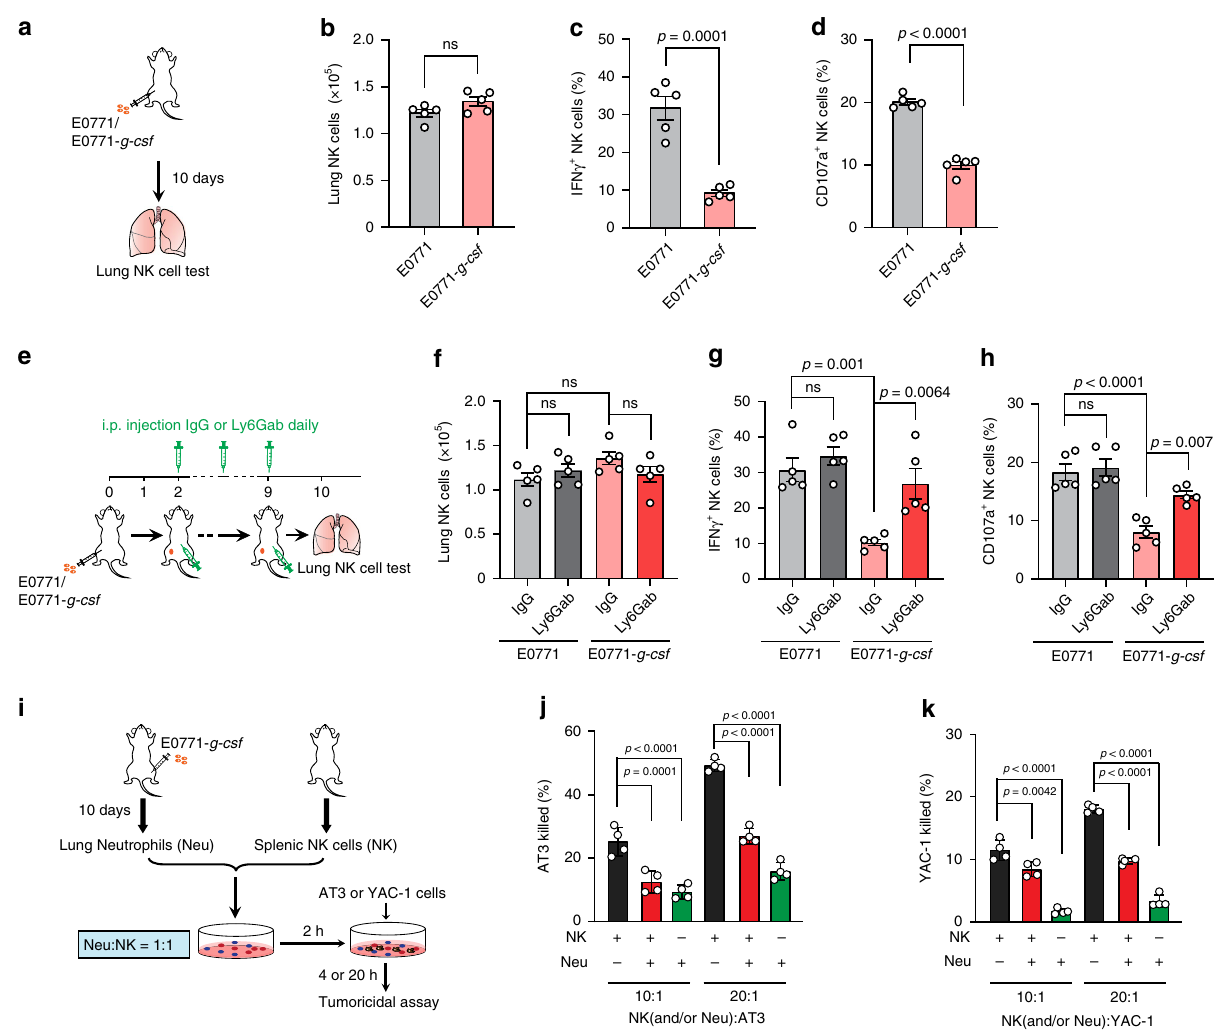
Fig. 4 Neutrophils inhibit the tumoricidal activity of NK cells. a – d Neutrophilia induced effector NK cell suppression in the pre-metastatic lungs. As depicted in a , NOD- scid mice were orthotopically injected with E0771 or E0771- g-csf cells. The mice were sacri fi ced at day 10. The total numbers of lung- in fi ltrating NK cells were calculated upon analysis by fl ow cytometry ( b ), and the percentages of IFN γ + ( c ), and CD107a + effector NK cells ( d ) were determined by fl ow cytometry. n = 5 mice per group. P values were determined by unpaired two-tailed t -test. e – h Depletion of neutrophils abolished tumor cell G-csf -overexpression-induced NK cell suppression. As depicted in ( e ), E0771 or E0771- g-csf cells were orthotopically implanted in NOD- scid mice, and the mice received control IgG or anti-Ly6G (Ly6Gab) daily 2 days after tumor cell implantation. The mice were sacri fi ced at day 10, and the total number of lung-in fi ltrating NK cells were calculated upon analysis by fl ow cytometry ( f ). The percentages of IFN γ + ( g ) or CD107a + effector NK cells ( h ) were determined by fl ow cytometry. n = 5 mice per group. P values were determined by one-way ANOVA with Tukey ’ s multiple comparisons test. i – k In i , a schematic diagram is to show the experimental design in j , k . Neutrophils were freshly isolated from the lungs of E0771- g-csf orthotopic tumor-bearing NOD- scid mice, and NK cells were derived from spleens of naïve NOD- scid mice. An ex vivo cytotoxicity assay was performed in a co-culture system including neutrophils, NK cells and tumor cells (3 × 10 4 AT3 cells or 1 × 10 4 YAC-1 cells), with the ratios of neutrophil: NK cell: tumor cells at 10:10:1 or 20:20:1. The percentages of AT3 cells ( j ) and YAC-1 cells ( k ) killed by neutrophils and NK cells individually or together were determined. P value was determined by one-way ANOVA with Tukey ’ s multiple comparisons test. Data are represented as mean ± SEM ( b – d , f – h ) or mean ± SD of four biologically independent cell cultures ( j , k ). ns not signi fi cant. Source data are provided as a Source data fi